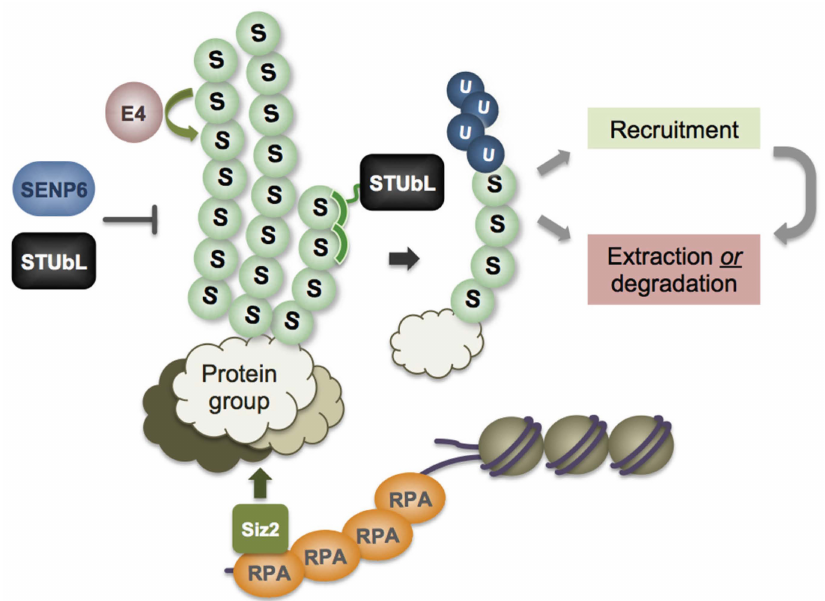
Figure 1. DNA damage promotes recruitment of sumoylation enzymes and crosstalk between the SUMO and ubiquitin pathways. In the process of repairing a DSB, resection generates ssDNA, which is coated with RPA. Through interaction with RPA, SUMO E3 ligase Siz2 is recruited to the damage site to promote the sumoylation of protein groups involved in DNA repair. SUMO-SIM contacts create a glue effect to enhance protein-protein interactions and the recruitment of additional